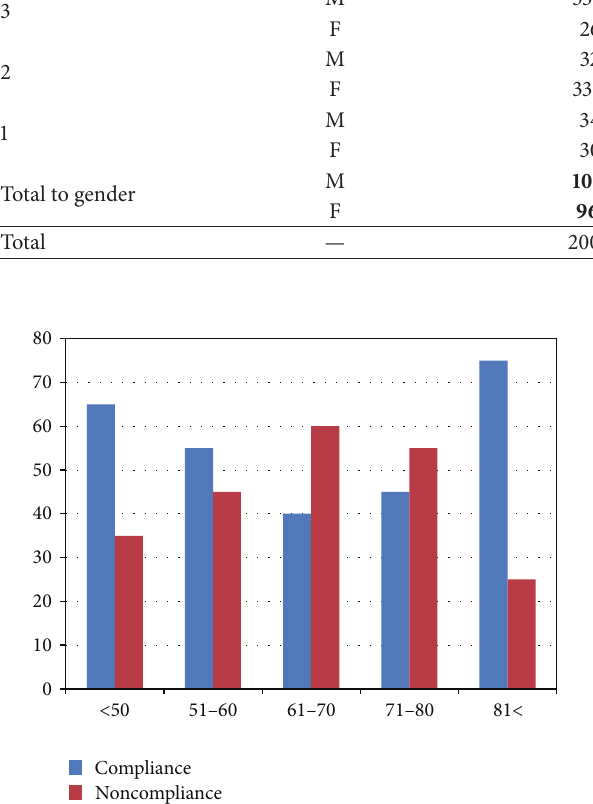
Figure 2: General compliance rates (white) and noncompliance (black) among subjects, according to age groups. 𝑃 value represents the result of paired 𝑡 -tests. Age categories < 50 and > 81 showed sig- nificant difference in compliance ( 𝑃 < 0.05 ).